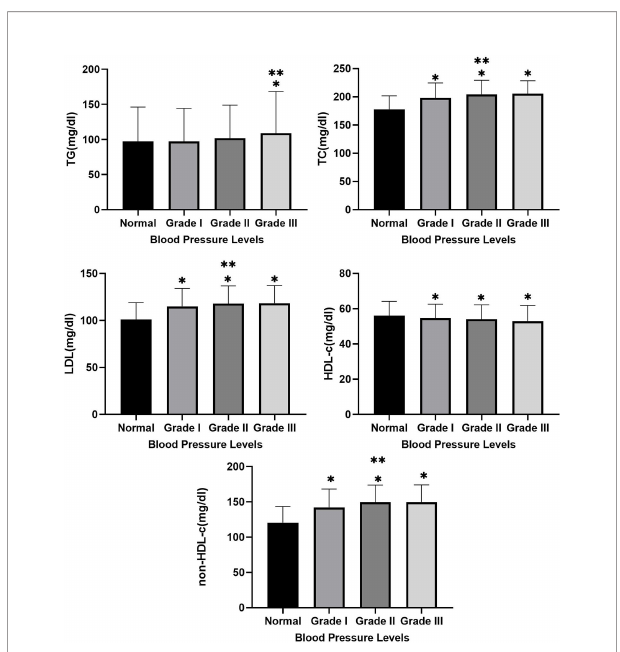
FIGURE 2 | Between-group differences in TC, TG, LDL, HDL-c, and non- HDL at different blood pressure levels. * Indicates Grade I, Grade II and Grade III compared with normal group with p-value <0.05. ** Indicates Grade II and Grade III compared with Grade I with p-value